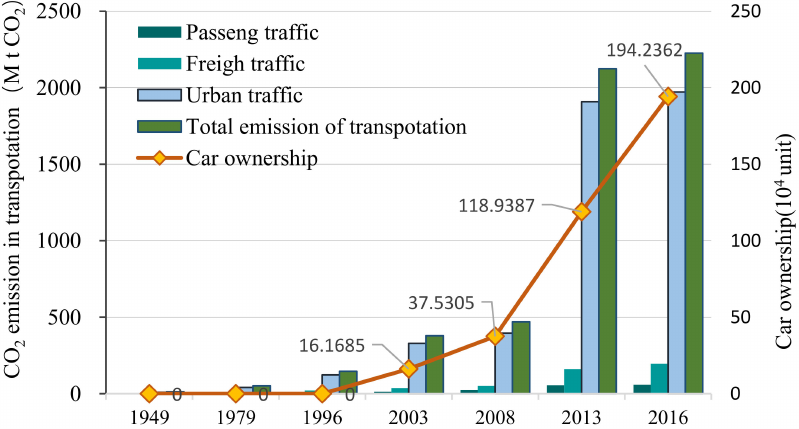
Figure 8. Growth trends of various transportation carbon emissions and car ownership